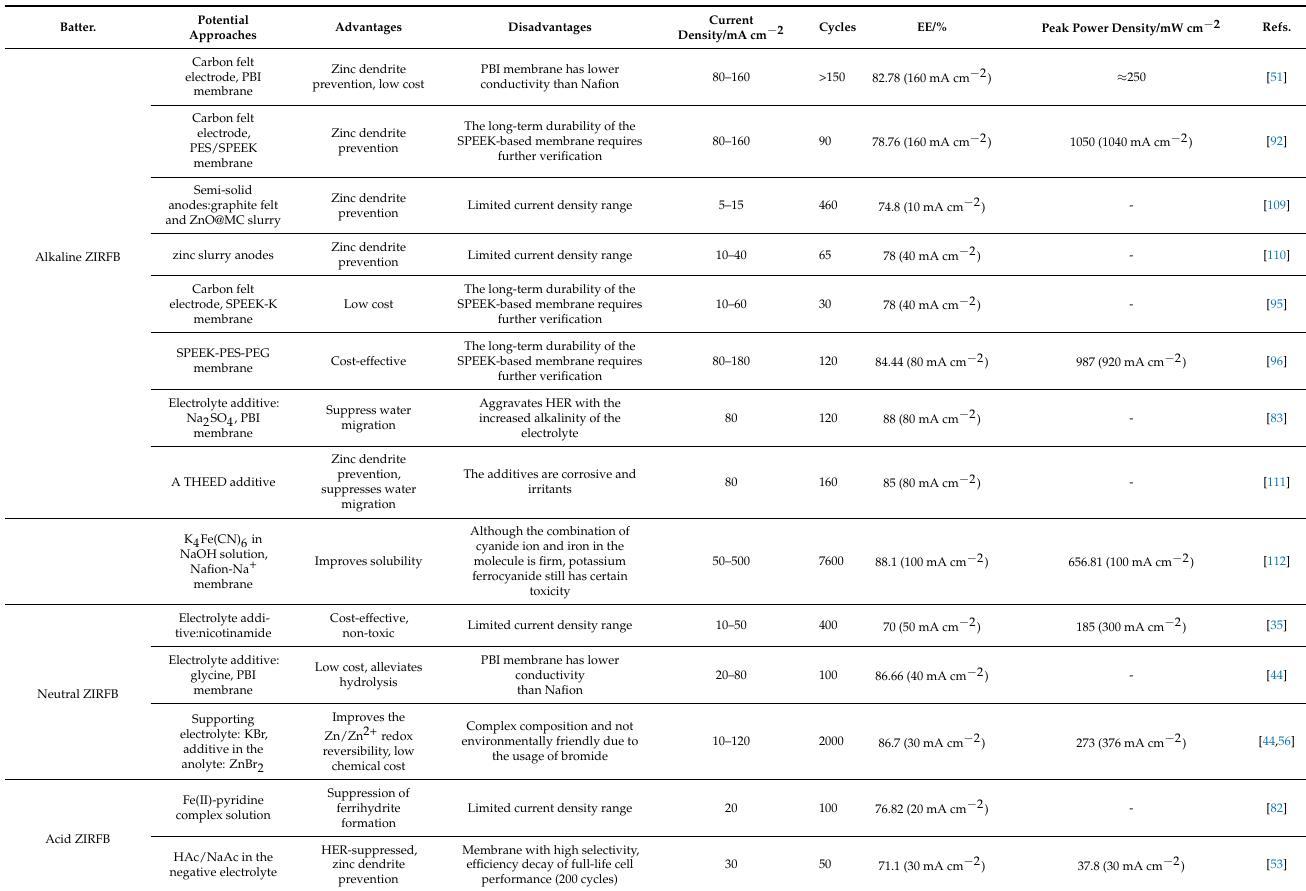
Table 5. The comparison with potential